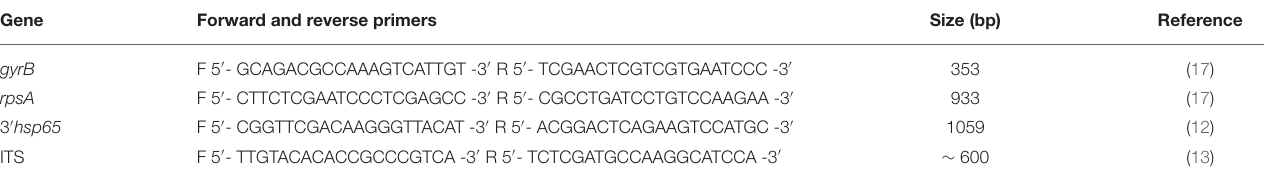
TABLE 1 | Primers used for PCR and sequencing. Gene